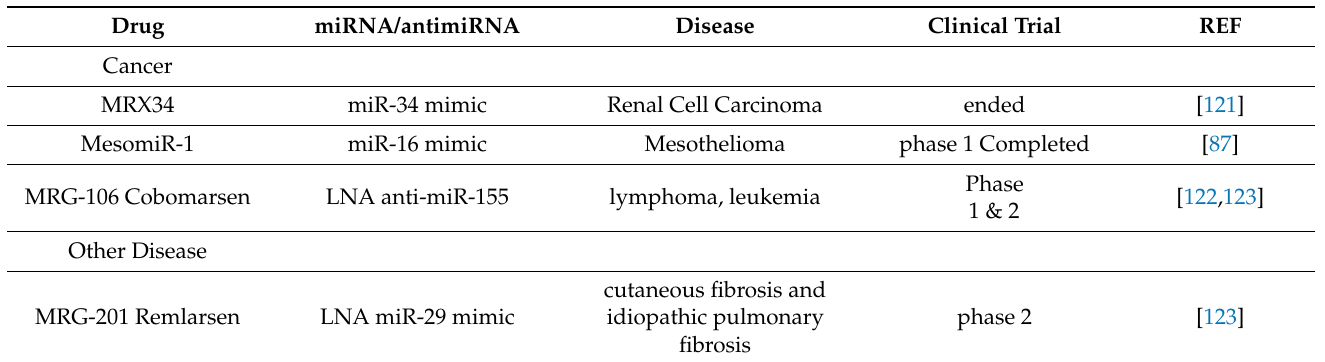
Table 4. Clinical trials using miRNAs or